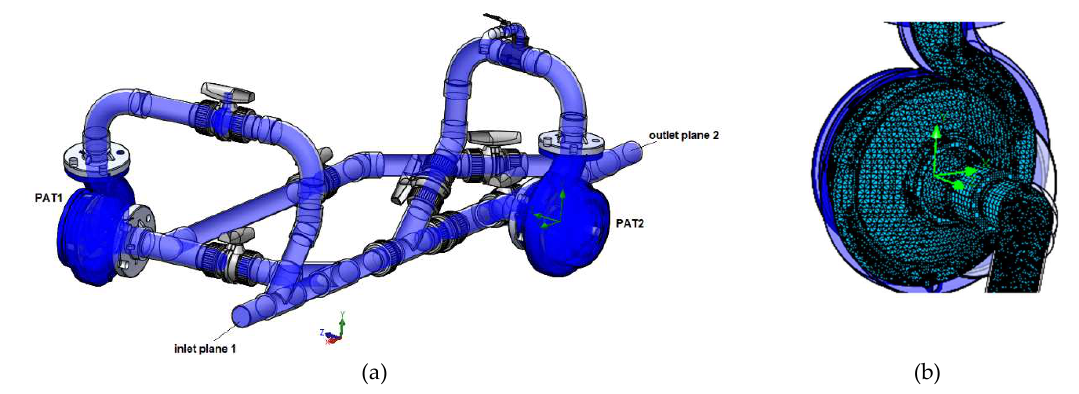
Figure 10. PAT system set-up: ( a ) fluid volume in PATs operating in parallel; ( b ) PAT geometry mesh.